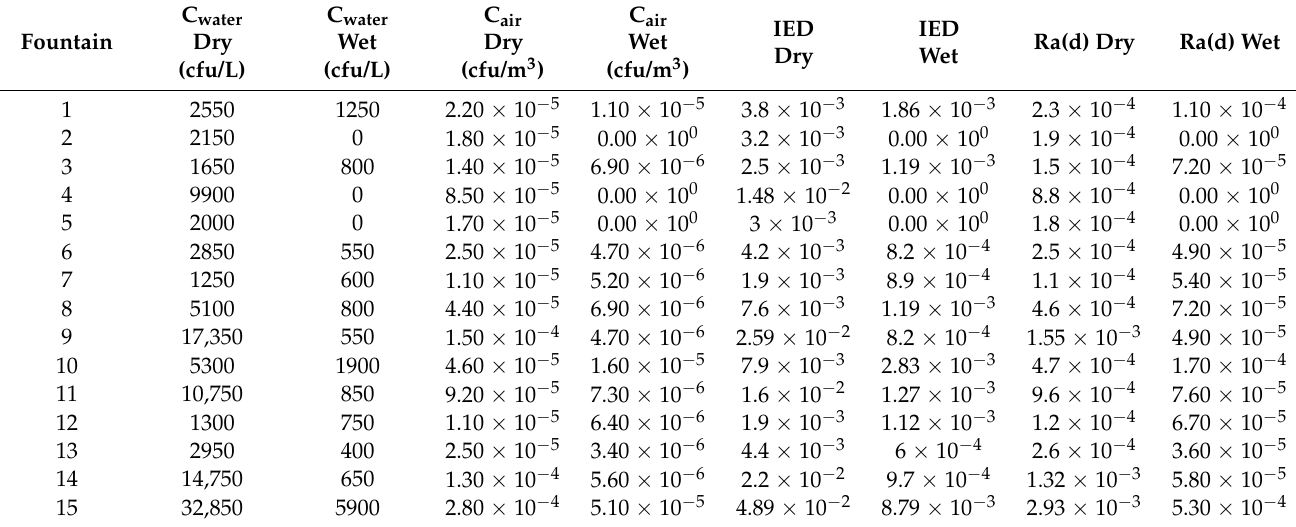
Table 4 . Legionella spp. concentrations (cfu/L) in water (C water ) and air (C air ) for fountains during the dry and wet periods. The average Legionella concentrations were based on the Legionella counts. The average concentrations in the air (cfu/m 3 ) were based on the water–air bacterial coefficients. The Legionella inhaled exposure doses (IEDs, cfu) from different fountains for each period are shown. Ra(d) was calculated based on the equations in Table 2.